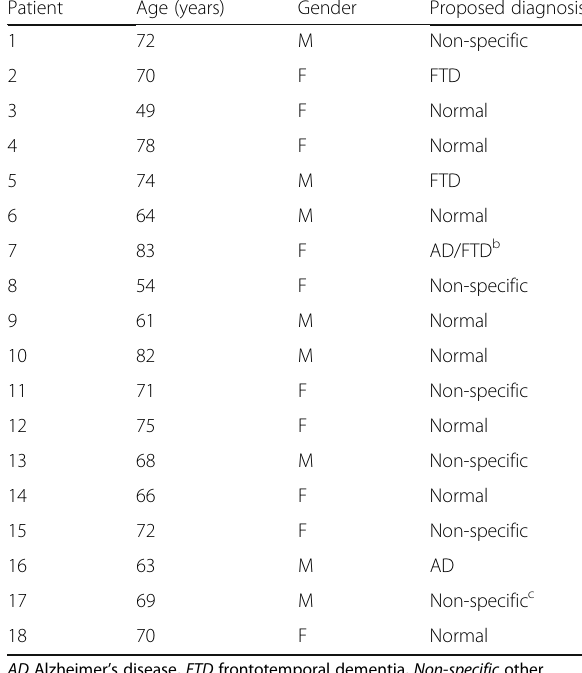
Table 1 Patient characteristics